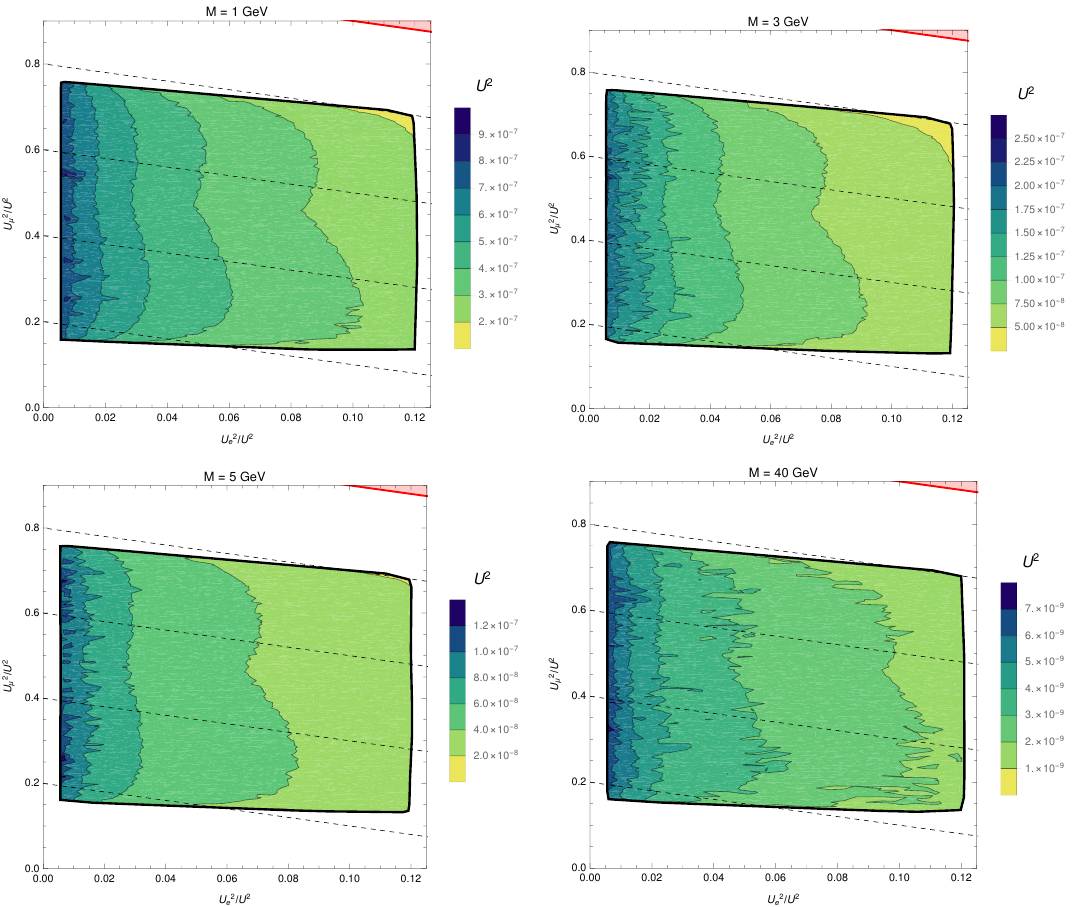
Figure 8 . Maximally allowed U 2 for given U 2 by leptogenesis. The four plots are for di(cid:11)erent Majorana masses M i : 1 GeV (top left), 3 GeV (top right), 5 GeV (bottom left) and 40 GeV (bottom right). These plots are shown in the U 2 U 2 =U 2 plane for normal hierarchy. The thick black lines display the region consistent with neutrino (cid:22) oscillation data, cf. the top panel of (cid:12)gure 1. U 2 and the iso- U 2 =U 2 lines are given by the dashed black lines. The red area indicates the forbidden (cid:28) region P U 2 =U 2 > a a